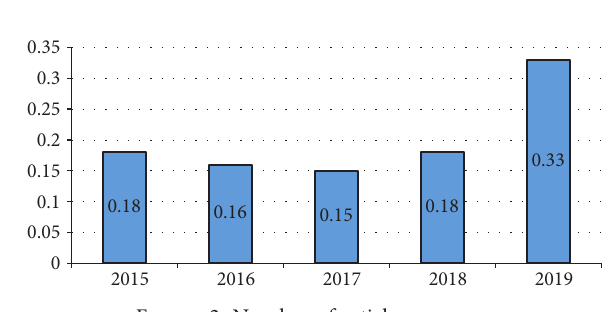
Figure 2: Number of articles per year.